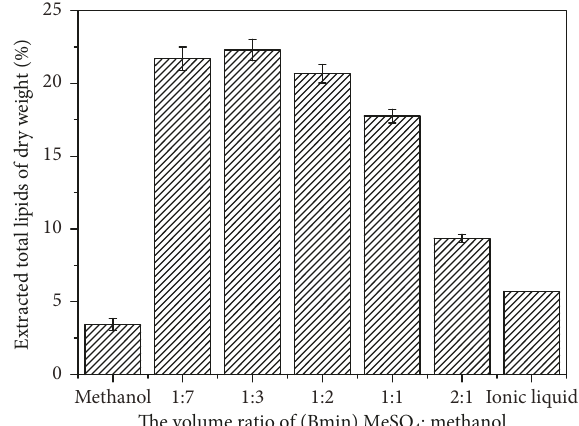
Figure 5: The in fl uence of volume ratio of [BMIM]MeSO methanol on lipid